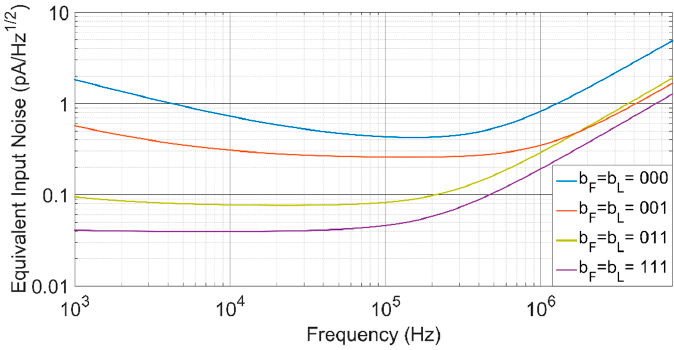
Figure 9. Equivalent input noise figure for the four gain configurations with 1.2 MHz bandwidth.